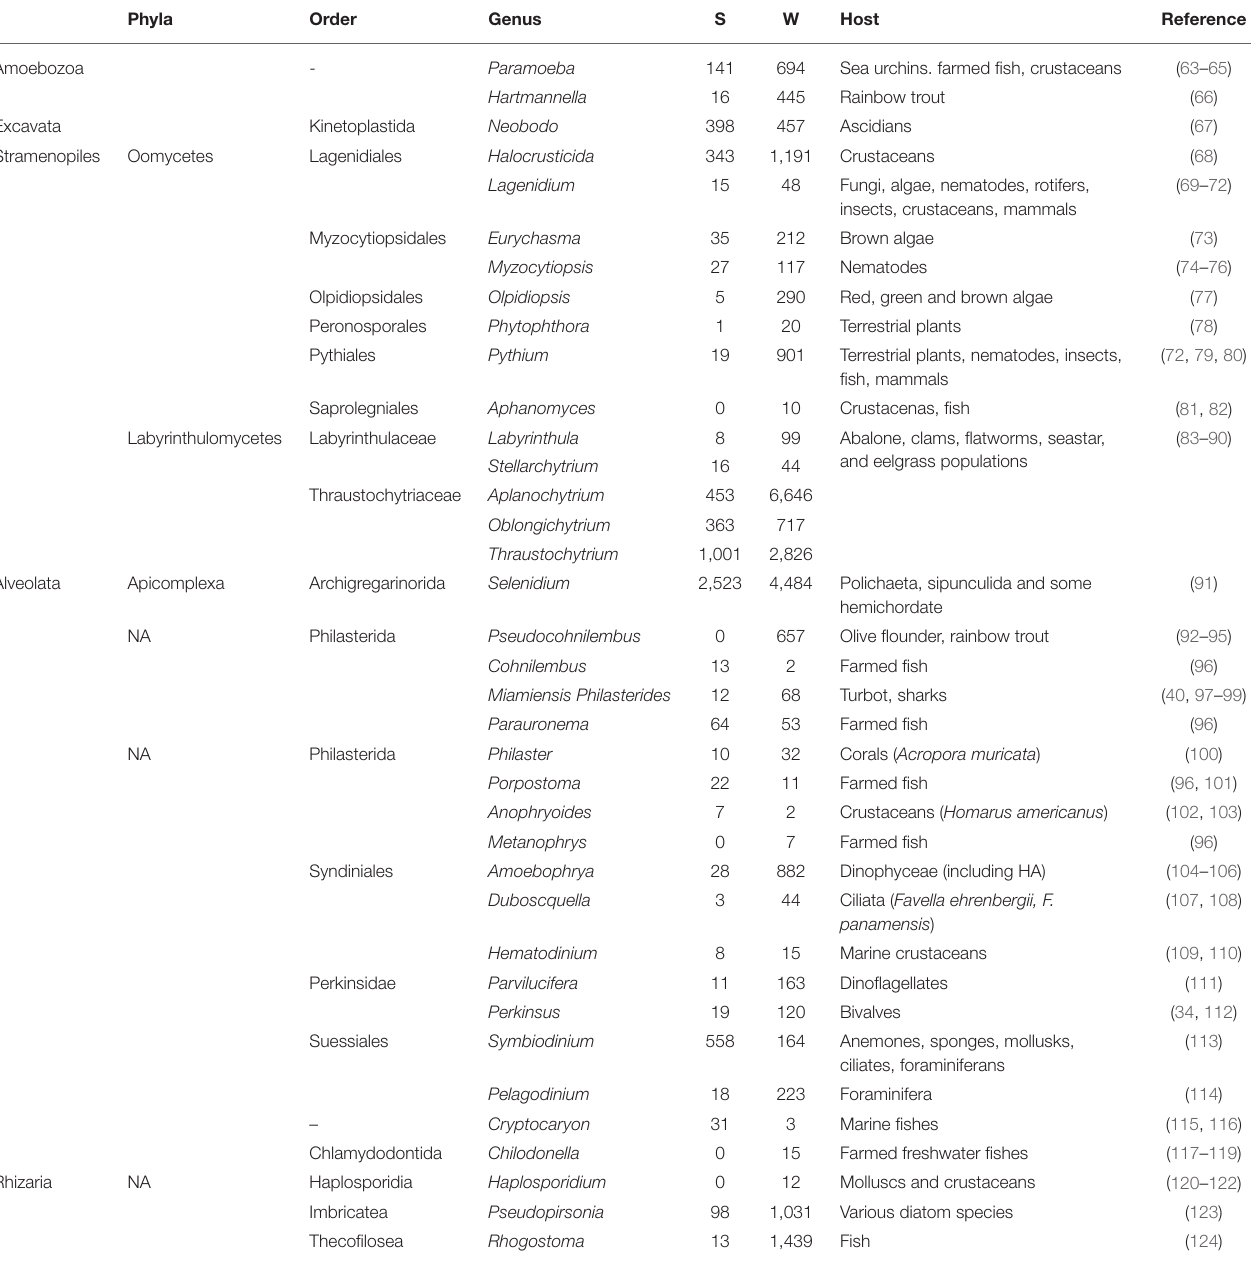
TABLE 5 | Diversity of potential protist pathogens detected in the